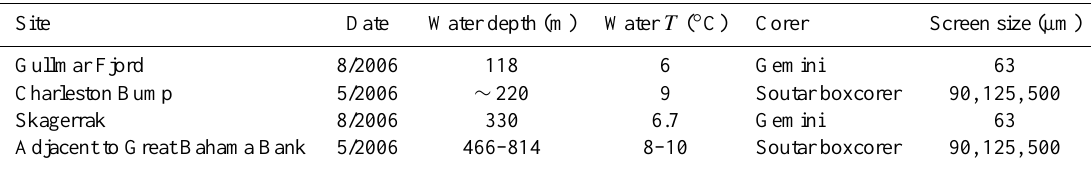
Fig. 1. Figure 1a Map showing sampling locations, indicated with crosses, in the NE Skagerrak and Gullmar Fjord (GF). Figure 1b. Sampling locations indicated with circles at Charleston Bump (CB) and Great Bahama Bank (GBB). Map from www.aquarius.ifm-geomar.de Table 1. Sampling details from the sites in the North